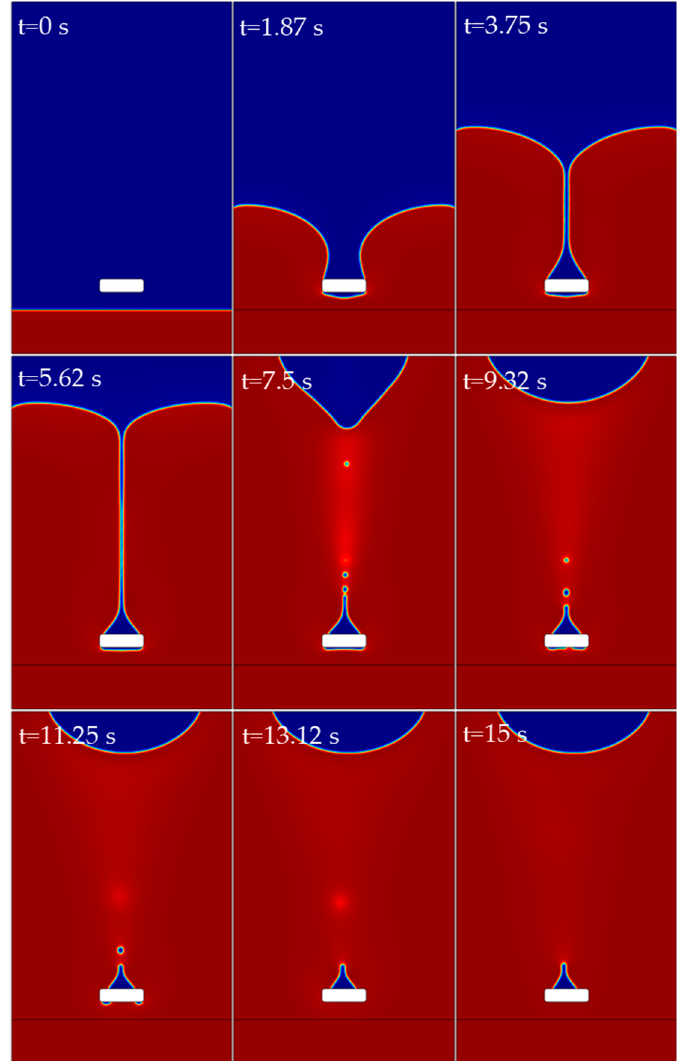
Figure 11. Resin flow around the steel wire when the corner radius is 0.3 mm.